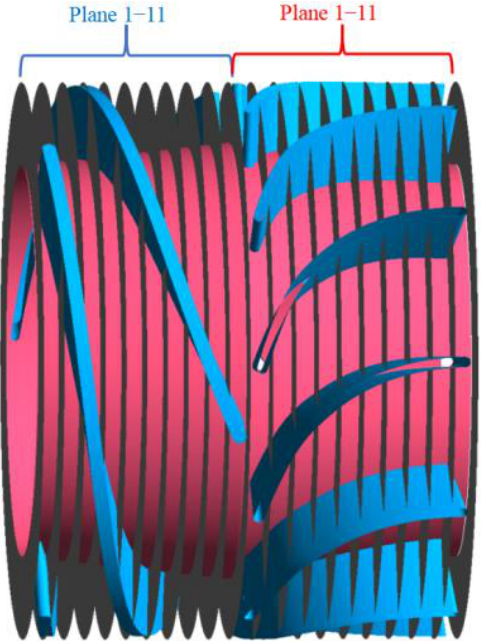
Figure 8. Schematic diagram of pressurization unit division of multiphase pump.